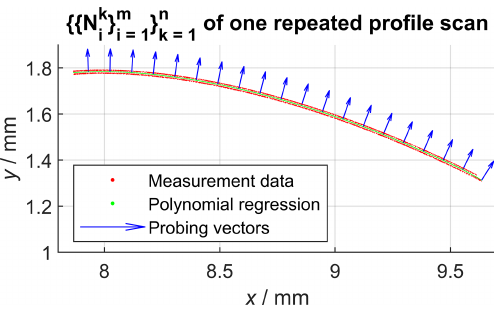
Figure 6. Projection of the calculated nominal geometry into the x – y plane. Measurement deviations perpendicular to the probing vector ( z component is zero) are not